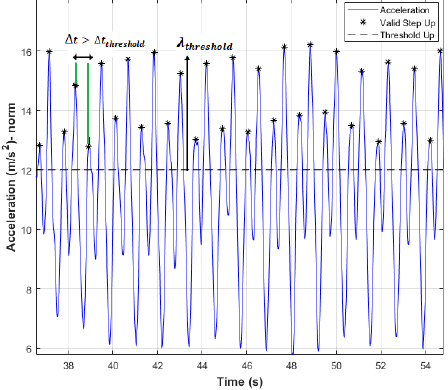
Figure 6. Detection of the valid steps for Swinging